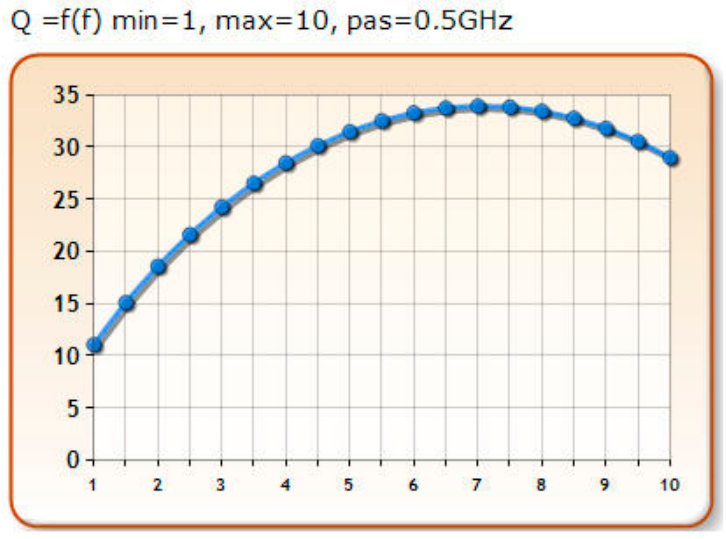
Figure 3. The quality factor variation vs. frequency for 3 turns spiral